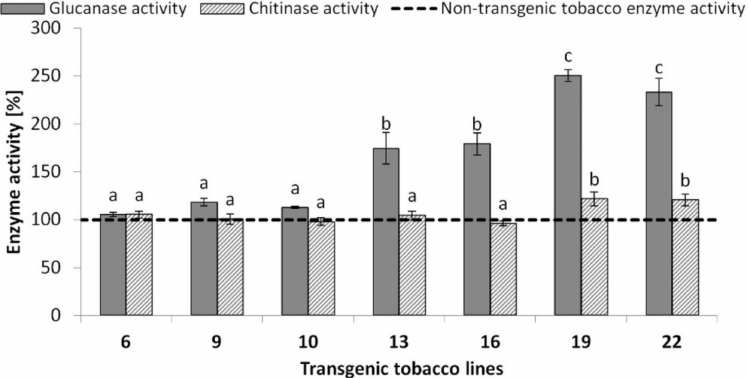
Figure 5. The 3,5-dinitrosalicylic acid (DNS) measurement of reducing sugars released by β -1,3- glucanase and chitinase, respectively, in crude protein extracts of transgenic tobacco lines and the non-transgenic control. a,b,c difference at p < 0.05 from the